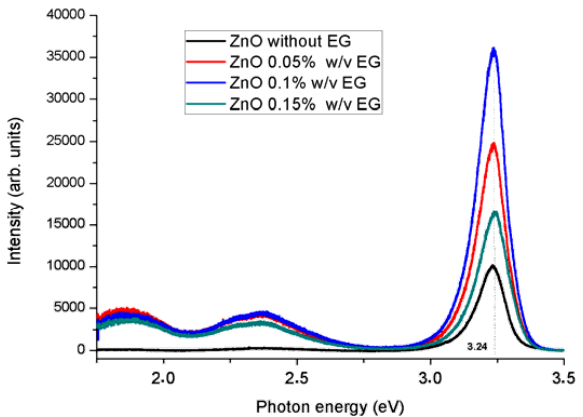
Figure 4. PL spectra of ZNRs grown on Au with and without presences of EG showing a sharp UV peak accompanied by two broad visible emission peaks.